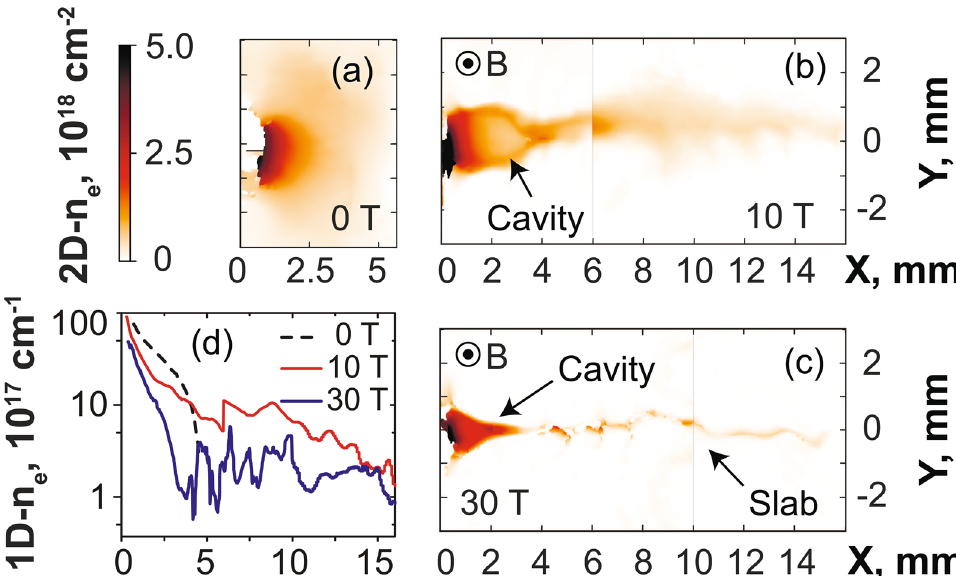
Figure 2. ( a–c ) 2D maps of the plasma electron density 40 ns after the laser irradiation on target (located on 0 ), for various strengths of the applied external magnetic field, as indicated. the left edge of the images at x = The color scale shown in ( a ) applies for all images. The images in ( b , c ) are reconstructed from two different shots with same parameters but obtained by moving the target within the diagnostic field of view, such that we can reconstruct a larger span of the plasma evolution. Patching this way two images obtained on two different shots is possible because the reproducibility of the results is very high, which is due to the external magnetic field generation having less than 1% variation from shot-to-shot 2 . ( d ) Corresponding radially integrated electron density as a function of the distance from the target, i.e. the 1D densities are obtained from 2D maps as shown in ( a – c ) and integrated over the axis Y. The lines correspond, respectively, to the case of a free expansion (black, 1 10 16 cm dashed), 10 (thin red) and 30 T (thick blue). The maximum noise level is about 1 , i.e. much lower − × than experimental